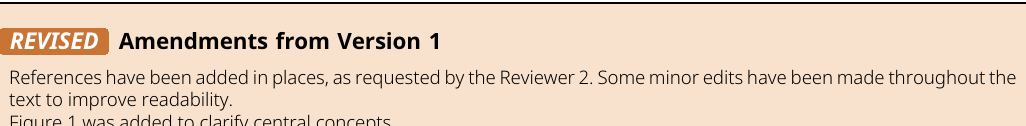
Figure 1. Definitions for central